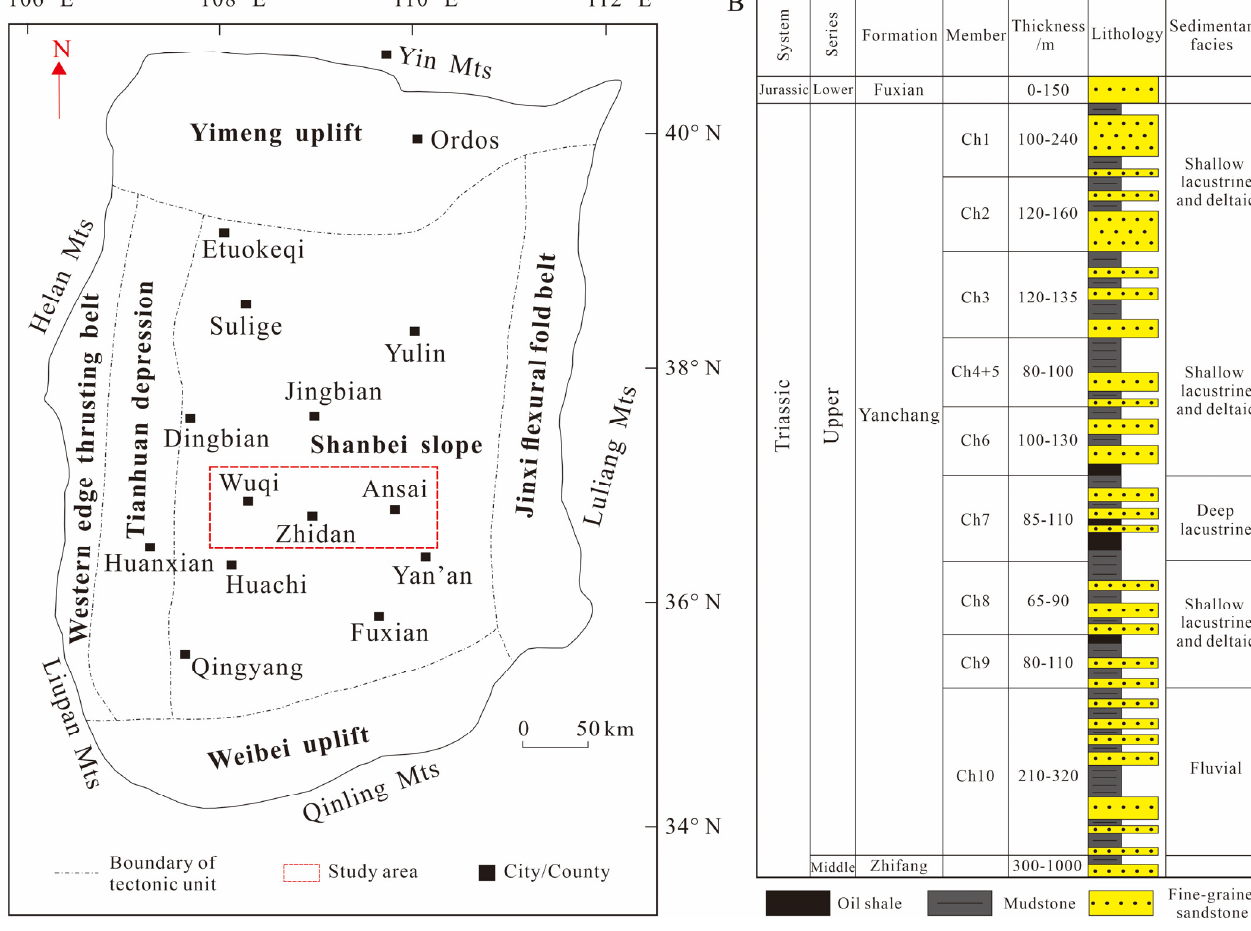
Figure 1. Location map and generalized Upper Triassic Yanchang Formation stratigraphy of the Ordos Basin. ( A ) Location of the Ordos Basin. ( B ) Generalized Upper Triassic Yanchang Formation stratigraphy of the Ordos Basin. Ch-Chang, Mts-Mountains.